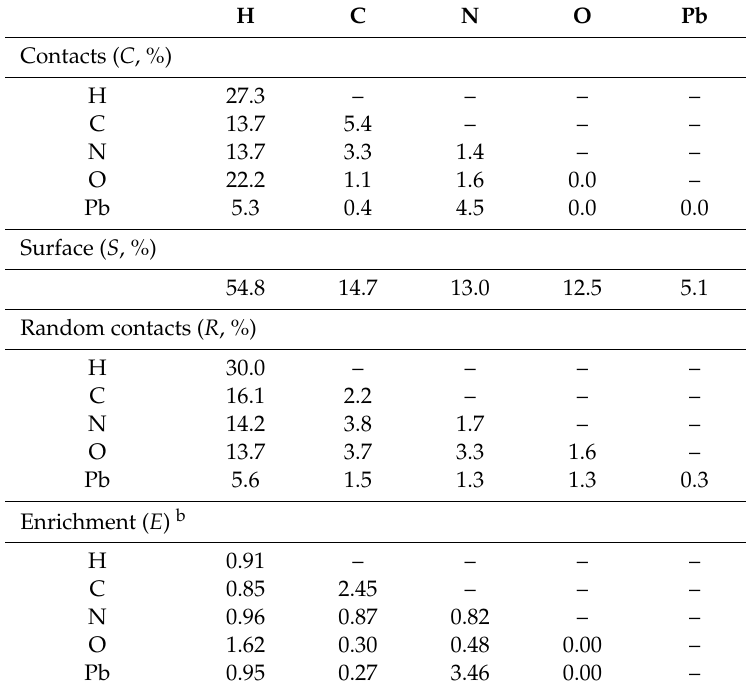
Table 4. Hirshfeld contact surfaces and derived “random contacts” and “enrichment ratios” for [PbL(NO 2 )] n a